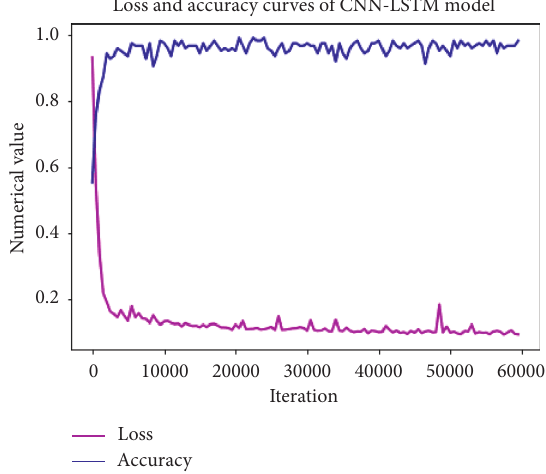
Figure 7: Loss and accuracy